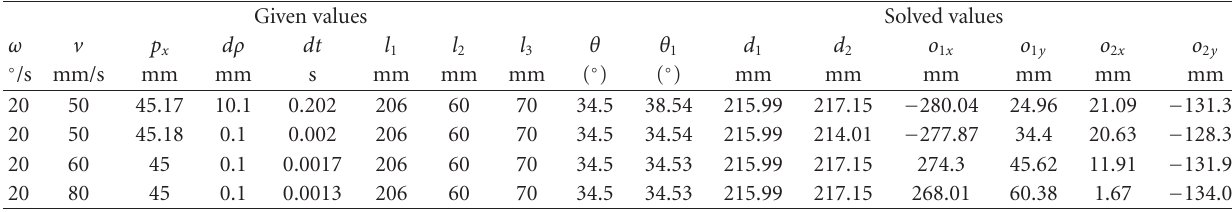
Table 1: The solved results of the planar four-bar linkage mechanism.